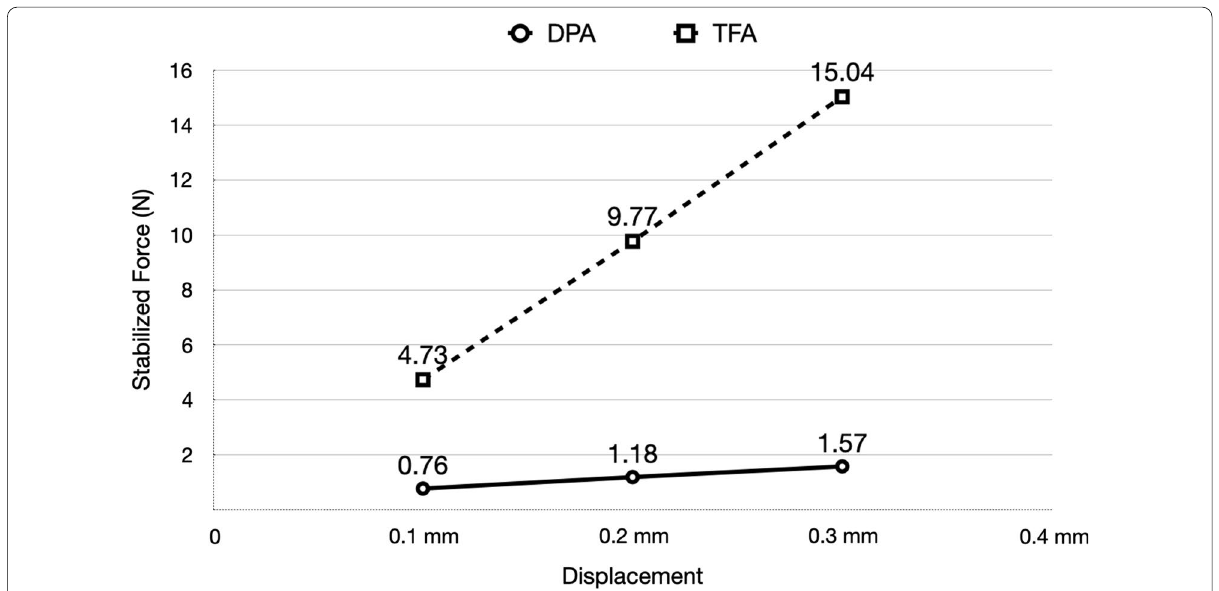
Fig. 5 Comparison of Stabilized Forces of TFA versus DPA